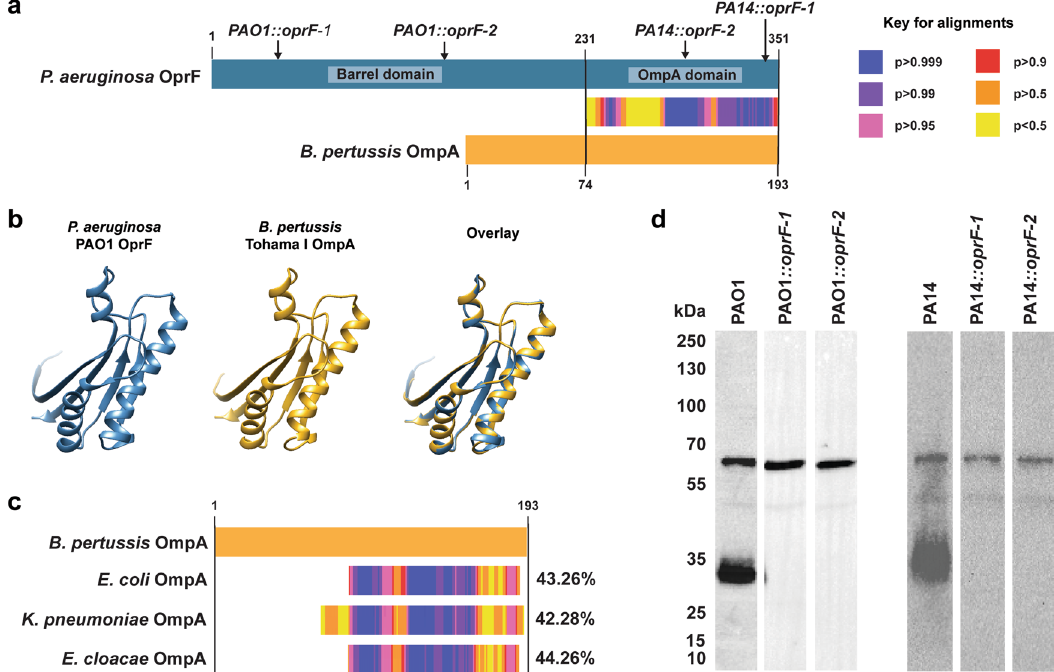
Fig. 5 Serum antibodies in B. pertussis whole cell immunized mice bind to P. aeruginosa OprF, which is homolog to B. pertussis OmpA. a LAST alignment of B. pertussis OmpA amino acid sequence to the P. aeruginosa OprF amino acid sequence. b Overlay of P. aeruginosa OprF OmpA domain and predicted B. pertussis OmpA protein. c Overlay of B. pertussis OmpA sequence to ESKAPE pathogen homologs, found in E coli , K. pneumoniae , and E. cloacae , with percent identity shown to the right. No homologs were identi fi ed in S. aureus , or A. baumannii , or Homo sapiens . d Western blot analysis of binding of cross-reactive antibodies to wild-type PAO1 and PA14 strains of P. aeruginosa , and to transposon mutants containing insertions in the oprF , as indicated in part A with an arrow. All blots in this panel were performed in